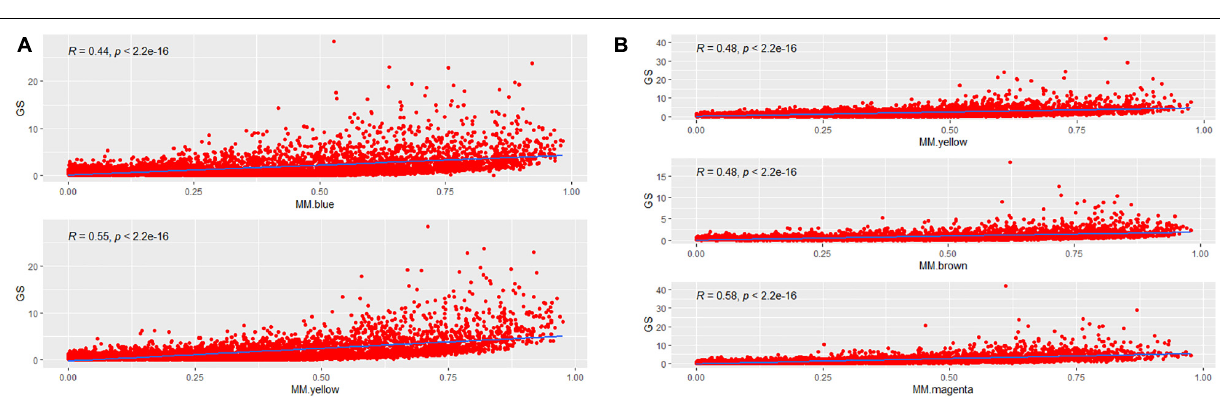
FIGURE 4 | The correlation between MM and GS. (A) The correlation between MM and GS for each of two AF-associated modules in LAA. MM for each module is plotted against GS. (B) The correlation between MM and GS for each of three AF-associated modules in RAA. GS, gene significance; LAA, left atrial appendage; RAA, right atrial appendage.